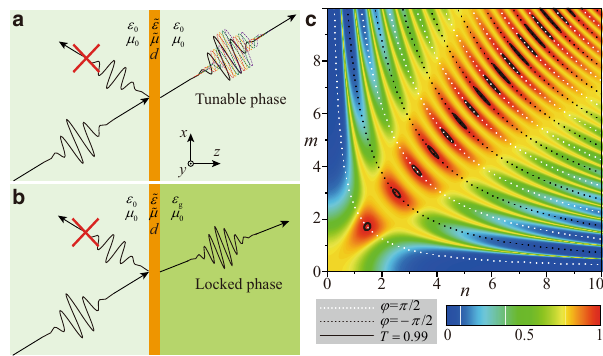
Fig. 1 Locked transmission phase in a homogeneous antire fl ection coating. a Schematic diagram of a layer of anisotropic homogeneous medium with thickness d , relative permittivity ~ ε and permeability ~ μ in free space. An oblique incidence with the incident angle α is considered. b Schematic diagram of a layer of anisotropic homogeneous medium located on the interface between the free space and a dielectric with relative permittivity ε g . c Calculated ffiffiffiffiffiffiffiffiffiffiffiffiffiffiffiffiffiffiffiffiffiffiffiffiffiffiffiffi q Fig. 2 Meta-atoms of the gradient antire fl ection metasurface (GAM) for ffiffiffiffiffi p ε μ (cid:2) sin 2 α = μ transmittance T as a function of m ¼ and n ¼ , , where μ “ invisible surface ” . a Schematic diagram of the re fl ection and refraction y z x x μ and ε are the x and z components of the relative permeabilit y and the y occurring on a dielectric surface under oblique incident waves. b Schematic y z diagram of the elimination of both re fl ection and refraction on the dielectric component of relative permittivity of the homogenous layer. White and black surface by utilizing a GAM. c Structures of the fi ve designed meta-atoms, dashed lines depict the contour plots of transmission phases of π = 2 and (cid:2) π = 2, which are all composed of 3-layer metallic patterns separated by two 1- respectively. Black solid lines represent contour plot of the transmittance of mm-thick dielectric spacers. The side length and thickness of meta-atoms 0.99. Here, d , α and ε g are set as 0 : 1 λ 0 , 45° and 4.4, where λ 0 is the are, respectively, p ¼ 7 : 73 mm and d ¼ 2 mm . Metallic sheets are used on wavelength in free the left and right sides of each meta-atom to suppress the mutual coupling T = 0.99. The white and black dashed lines depict the contour between neighboring meta-atoms. d Simulated spectra of transmittance plots of transmission phases of π / 2 and − π / 2, respectively. It can (upper panel) and transmission phase (lower panel) for the fi ve designed be seen that high transmittance can only be obtained when the meta-atoms on the interface between the free space and a dielectric transmission phase is either π / 2 or − π / 2, which is consistent with material with its relative permittivity of 4.4. The gray shadow depicts a the above theoretical analysis. frequency range from 9.92 to 10.07GHz, where the transmittances of all fi ve meta-atoms are >90%.